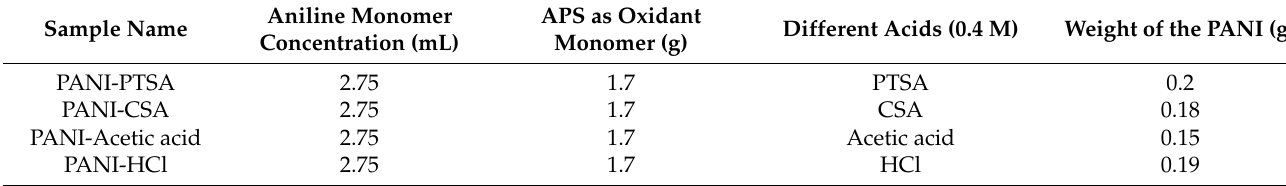
Table 1. Preparation of PANI samples.